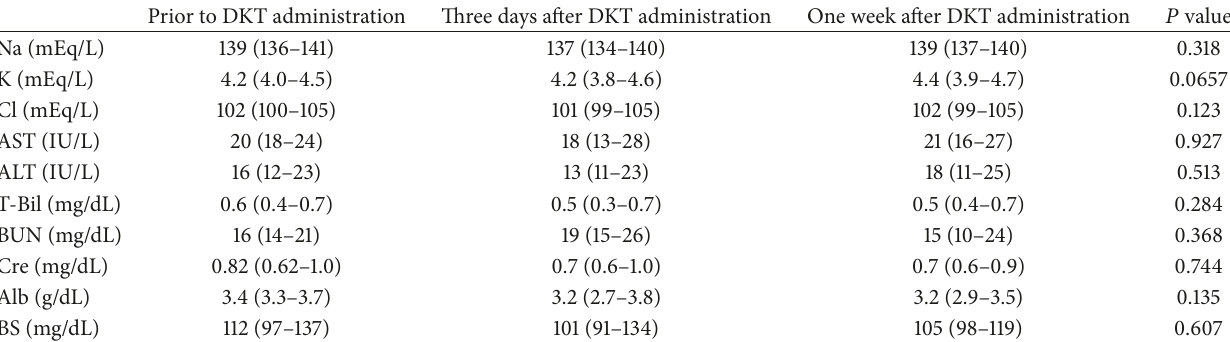
Table 3: Clinical laboratory data of patients.